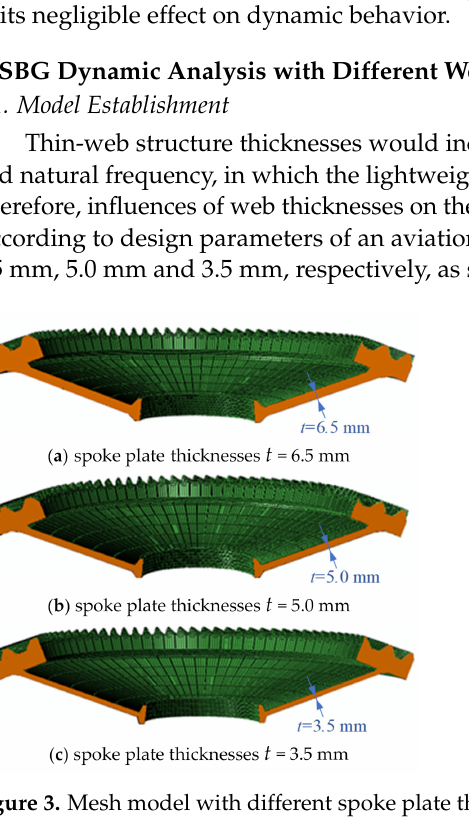
Figure 3. Mesh model with different spoke plate